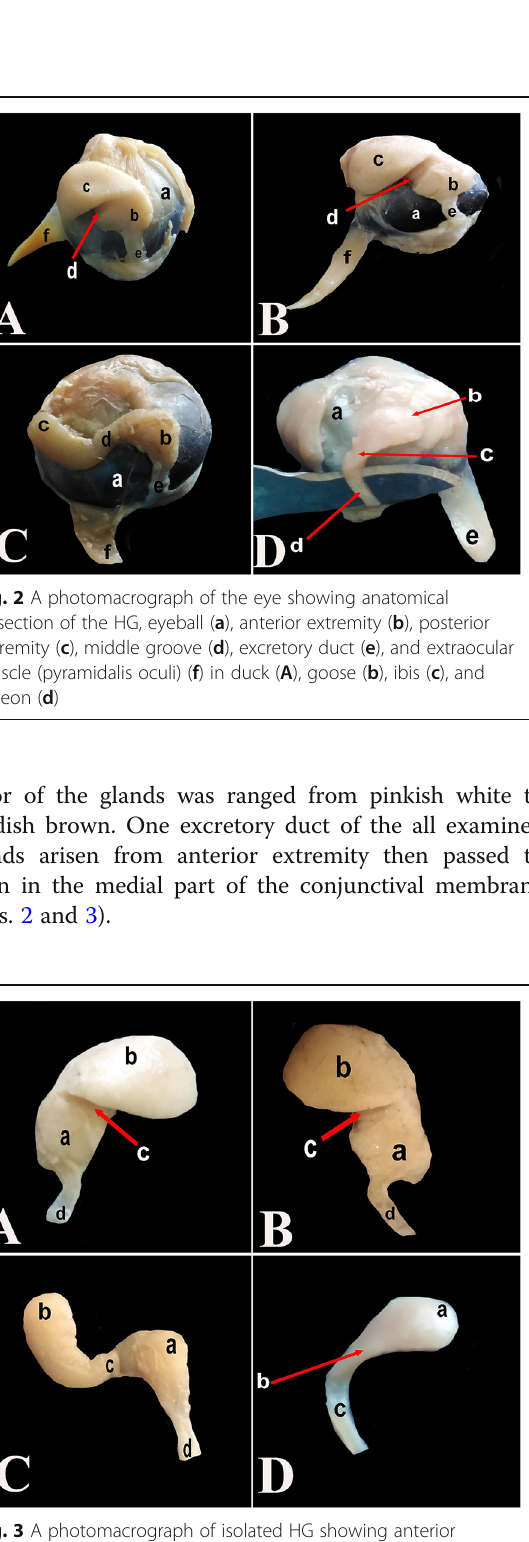
Fig. 3 A photomacrograph of isolated HG showing anterior extremity ( a ), posterior extremity ( b ), middle groove ( c ), and excretory duct ( d ) in duck ( a ) and goose ( B ). Isolated HG of ibis showing anterior extremity ( a ), posterior extremity ( b ), middle isthmus ( c ), and excretory duct ( d ) in C . Isolated HG of pigeon showing posterior broad extremity ( a ), anterior pointed extremity ( b ), and excretory duct ( c ) in